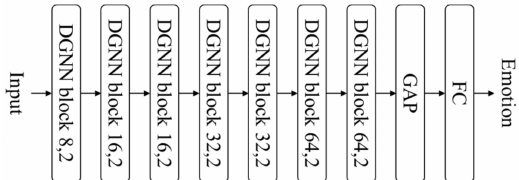
Figure 4. Network architecture used for the experiments. In the “DGNN block D , s ”, D and s denote depth and stride, respectively.